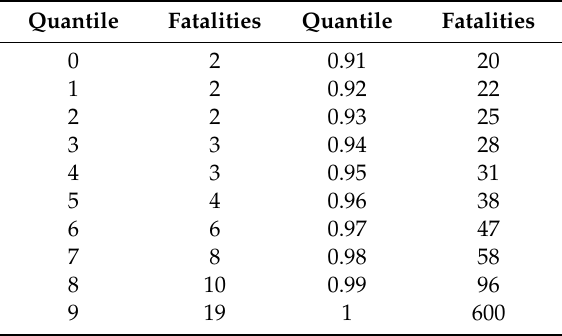
Table 1. Fatality quantiles of events in the Armed Conflict Location and Event Data (ACLED) dataset between 2012 and 2017 with at least 2 fatalities.